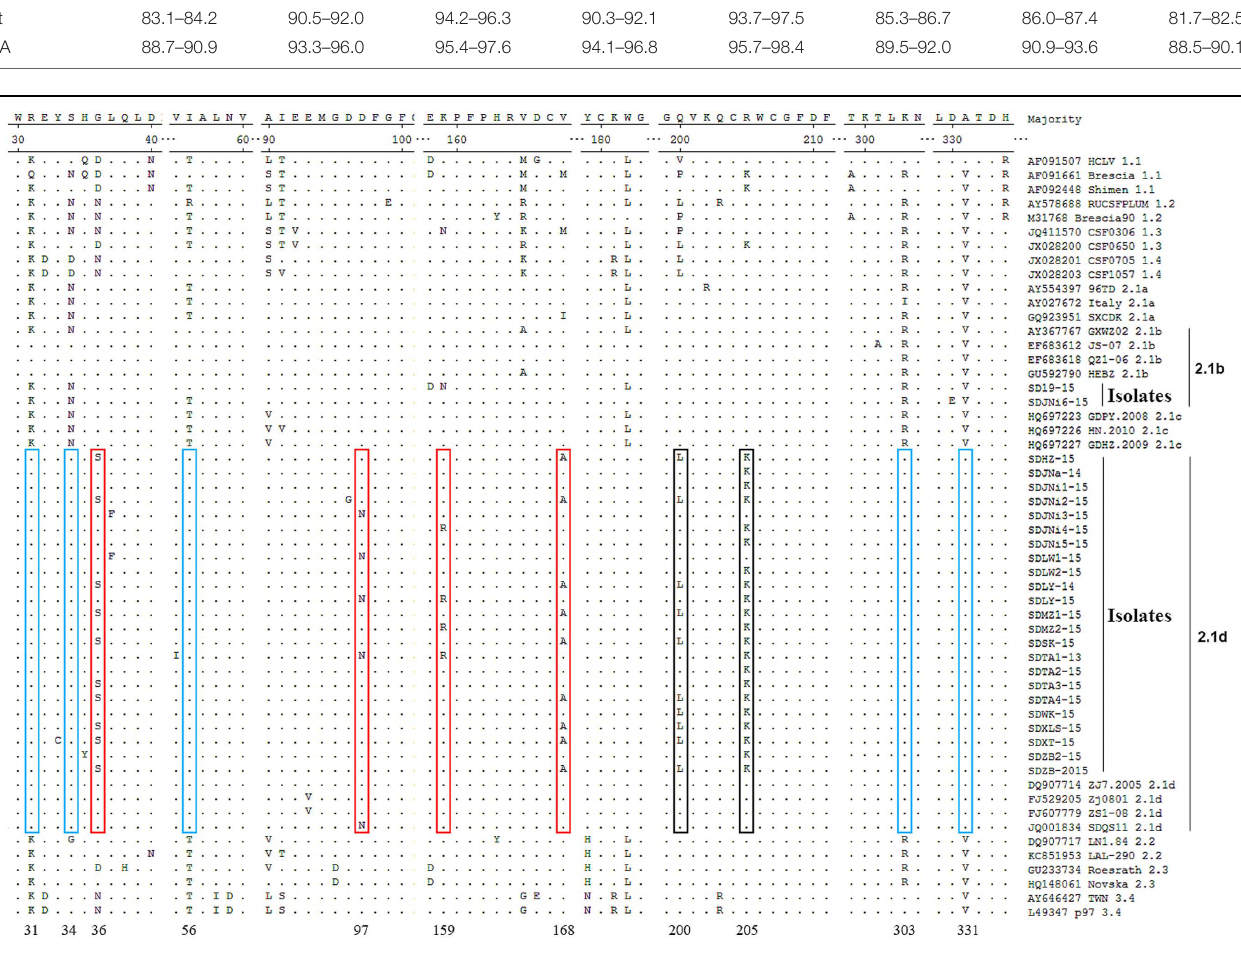
newly defined subgenotype 2.1d ( Figure 2 , Table 2 ).